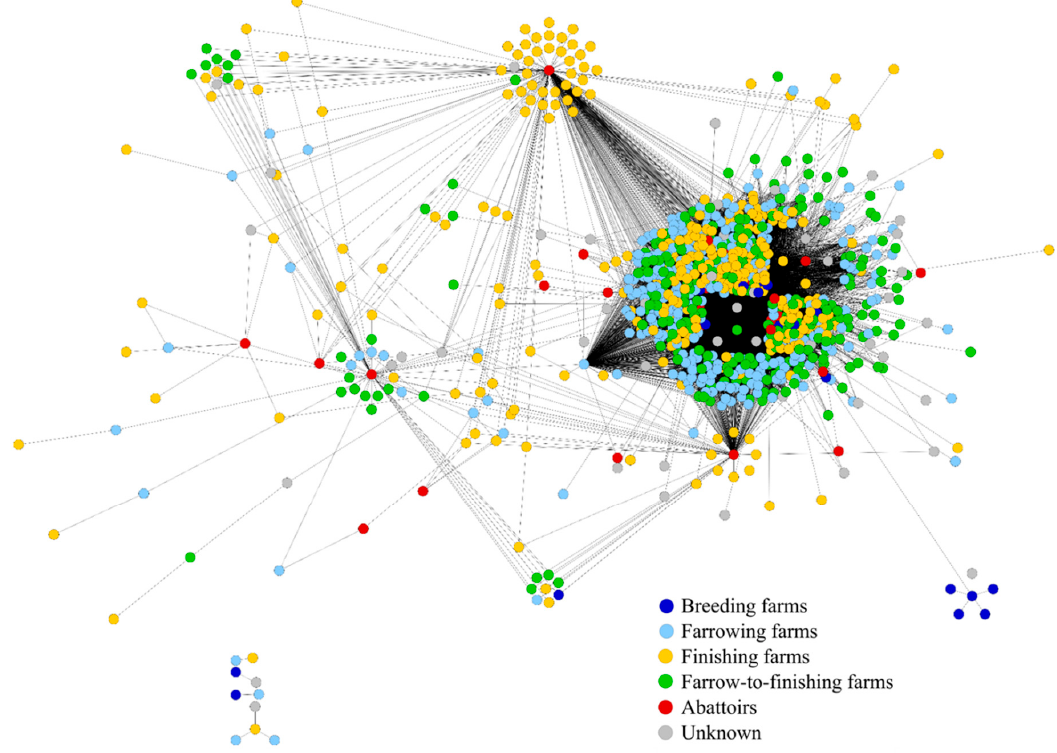
Figure 3. Projected transportation network (TR projected ) of a producer community in Northern Germany covering the observation period from 2013 to 2014. covering the observation period from 2013 to